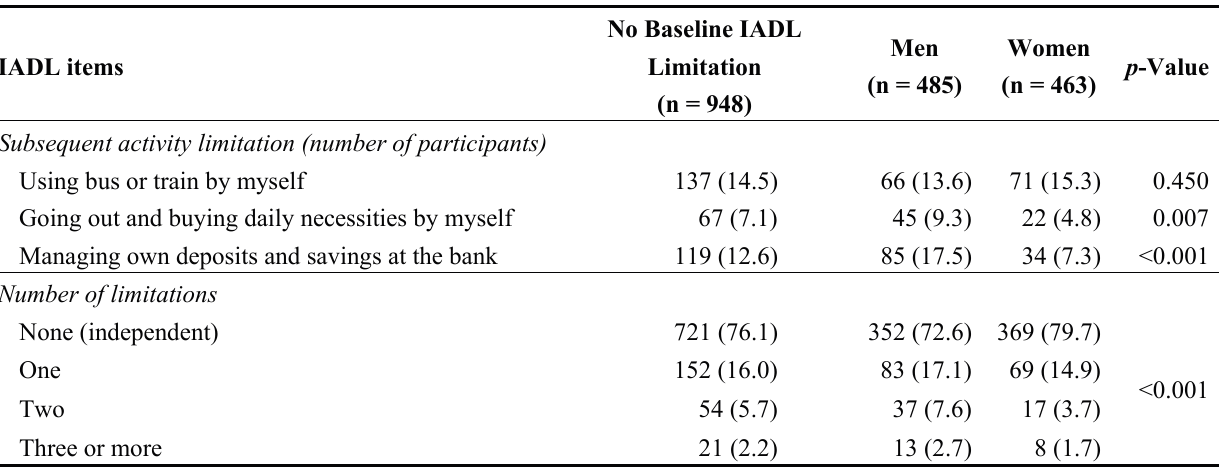
Table 2. Self-reported IADL limitation in the 15-month follow-up survey in participants without IADL limitation at baseline (n = 948).